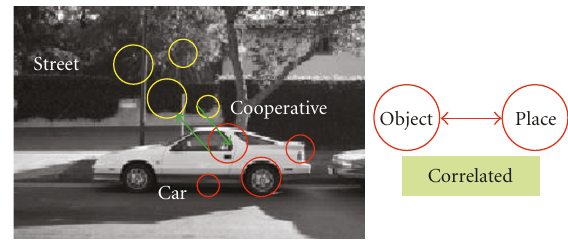
Figure 7: Strong correlation between object and background (place)